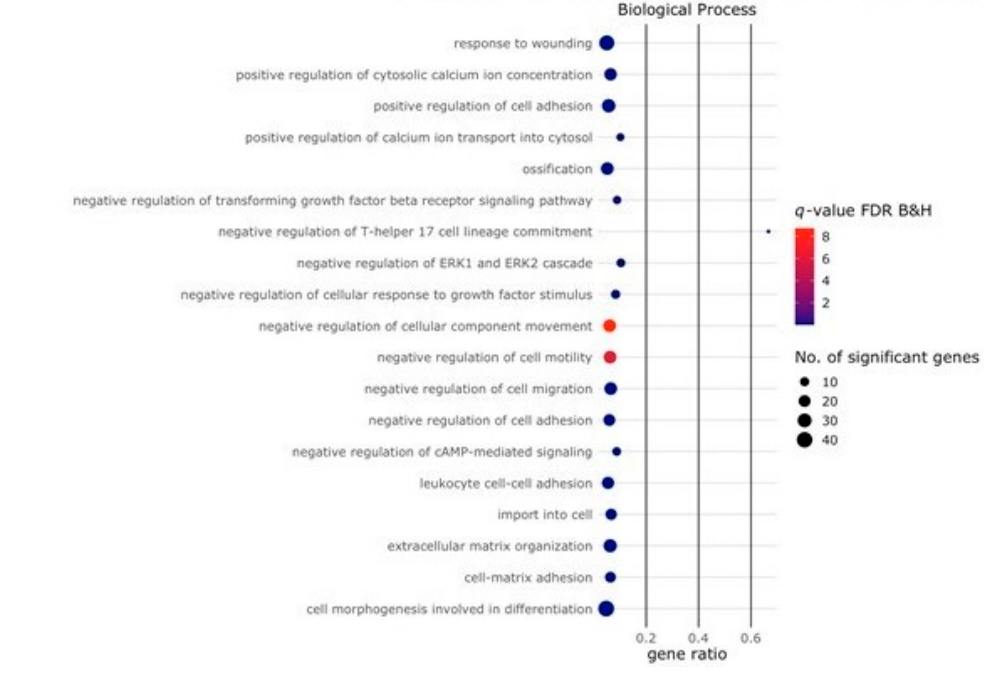
Figure 5. Gene ontology terms in the biological process domain. Bubble plot showing selected Gene Ontology (GO) terms in the biological process domain enriched among the genes that were upregulated or downregulated by the Activin-A treatment. The size of the circle represents the number of DEGs ( p (adj) < 0.01, Log2 fold change ≥ 2) in that pathway. The color of the circle represents the significance depicted as a q-value, with the default settings of the Benjamini–Hochberg false discovery rate (FDR B&H). ( A ) Selected GO terms were enriched among the upregulated genes could be divided into the different biological processes involved in cell fusion. The different stages of the cell fusion process are depicted in different colors ( B ) Selected GO terms enriched among the downregulated genes that could be linked to osteoclasts in